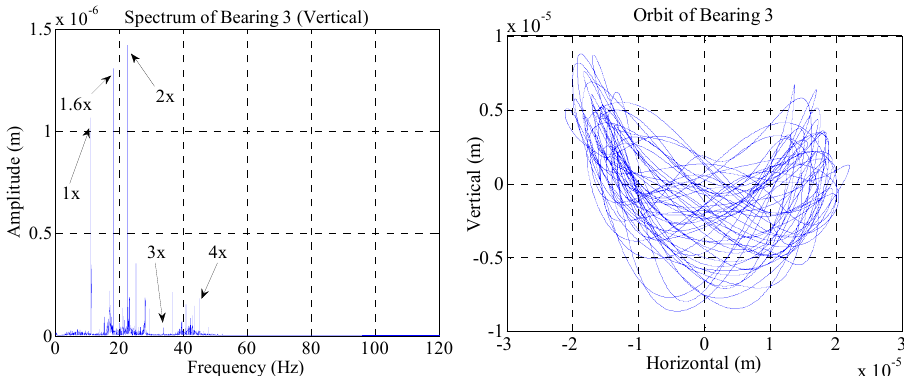
Figure 23. The spectrum and the orbit of Bearing 3.